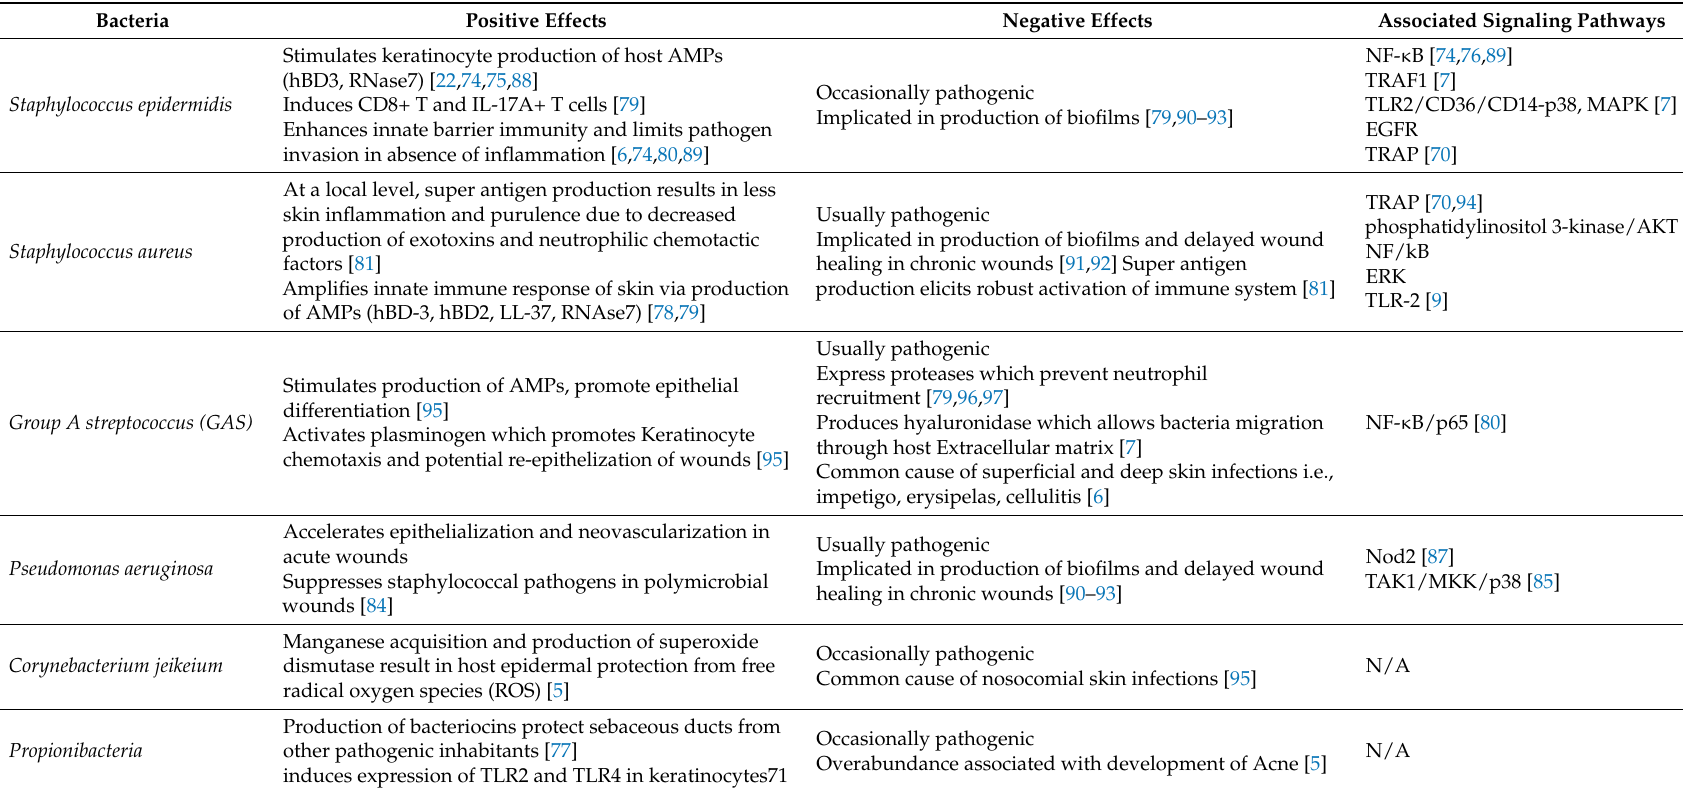
Table 1. Skin commensals have varying effects on host cutaneous tissue and are associated with a variety of cell signaling